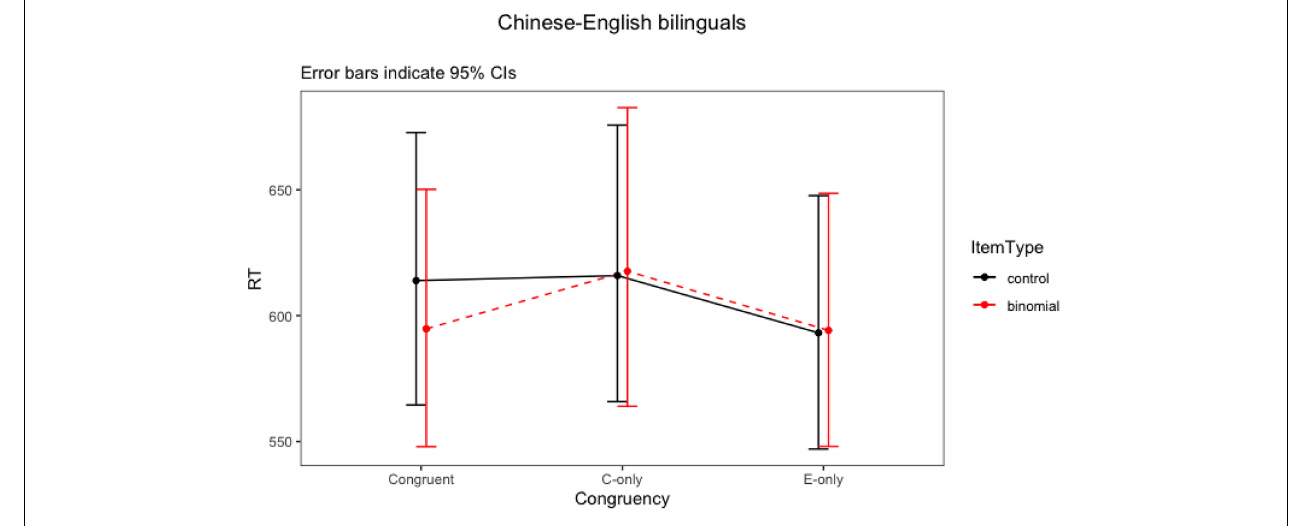
FIGURE 2 | Interaction plot of Item type * Congruency for Chinese-English bilinguals.